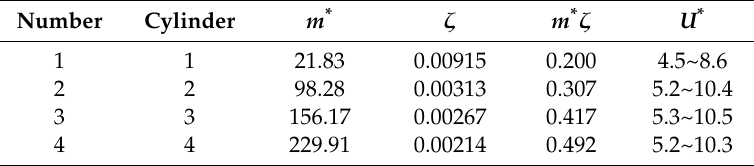
Table 3. Parameters of experiment II